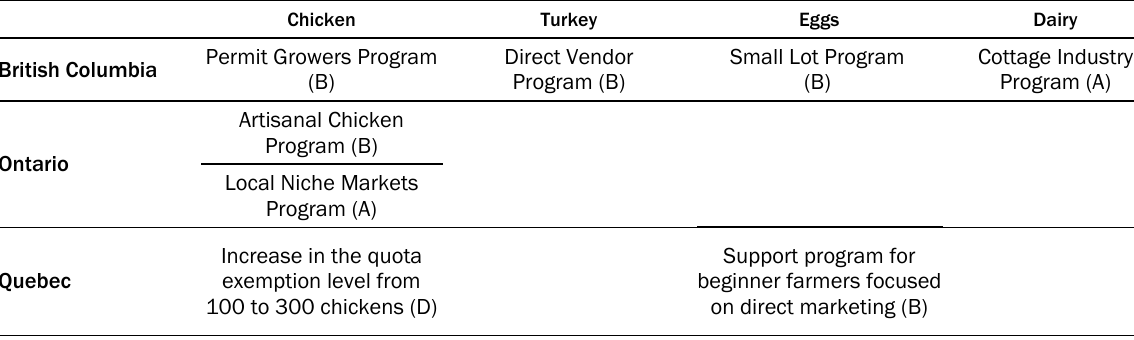
Table 3. Outline of the Programs Introduced to Support Small Producers in Short Supply Chains (and the Corresponding Policy Option)